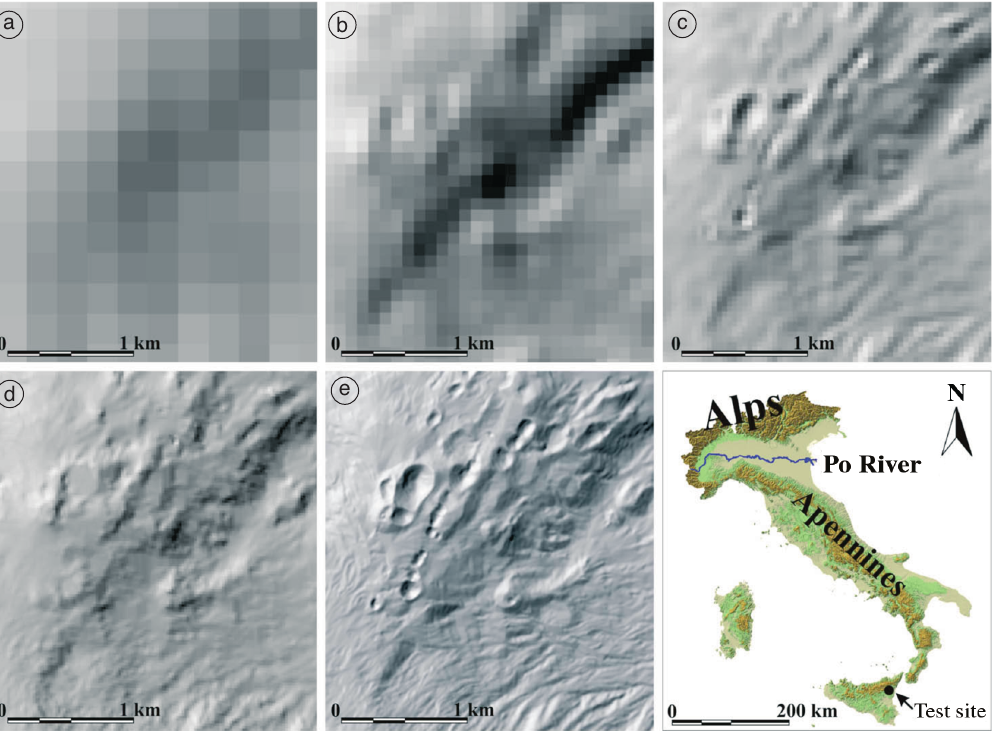
Fig. 1a-e. Shaded relief images (illumination from northwest) of samples of the available DEMs of Italy, repre- senting the northeast summit of Mt. Etna in Sicily. Bottom right panel: the map of Italy with the main mountain- ous areas and the test site location. North to the top. From the lower (a) to the higher (e) horizontal grid resolution: a) Archivio delle Quote Medie with a grid cell of 240 m; b) SRTM with a grid cell of 90 m; c) Terra-Italy/CGR with a grid cell of 40 m; d) IGM-1:25000 with a grid cell of 20 m; e) TINITALY/01 resampled to a 10 m grid